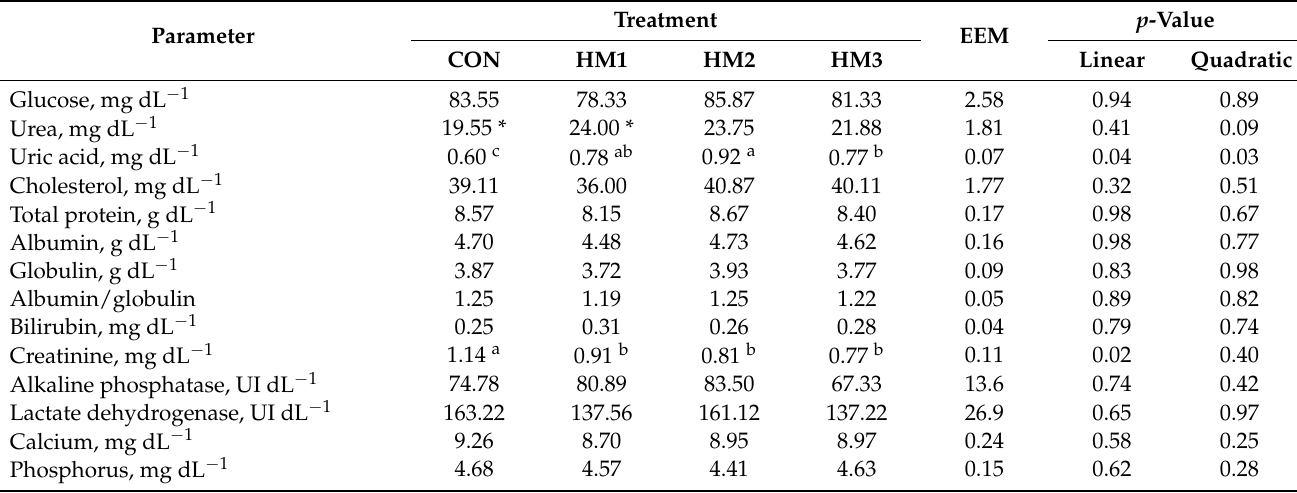
Table 6. Blood biochemical parameters of lambs supplemented with a polyherbal mixture 1 during the final fattening